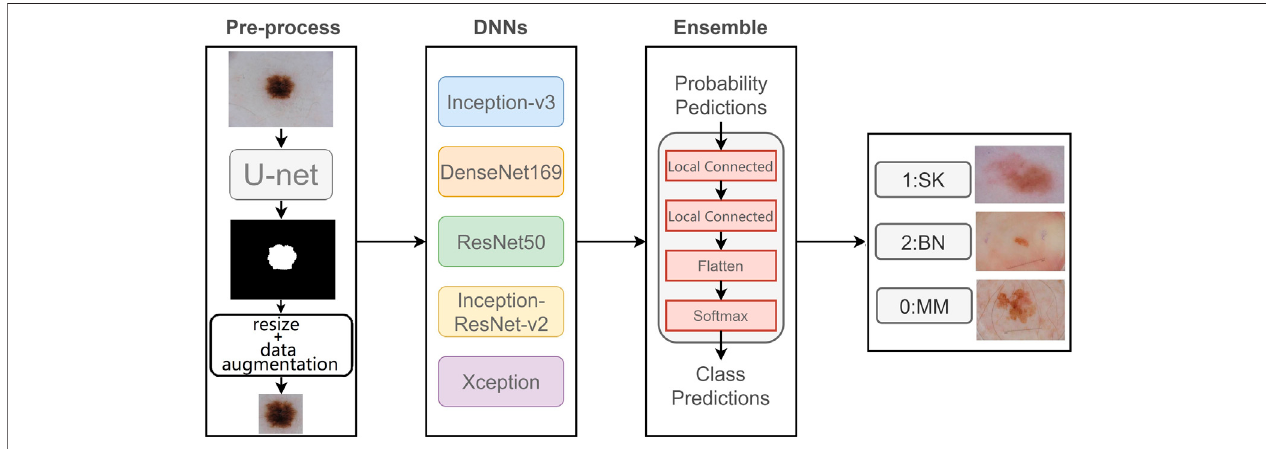
FIGURE 2 | Flowchart of our proposed